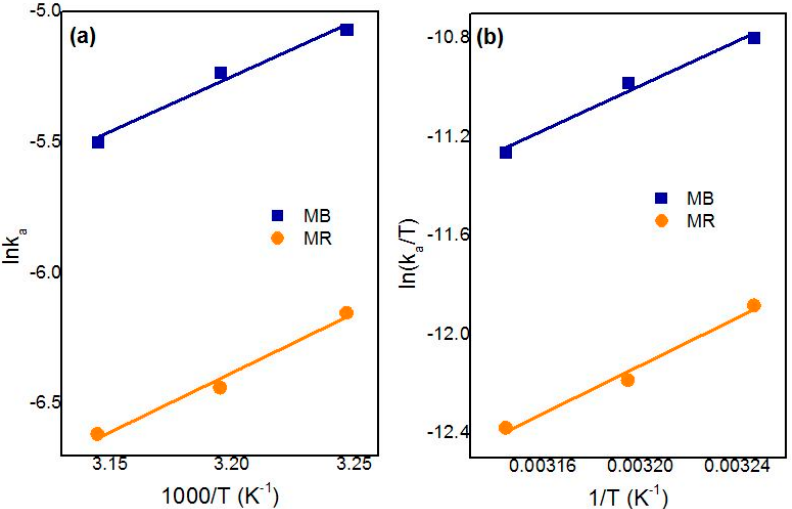
Figure 15. ( a ) Arrhenius plot and ( b ) Eyring plot for the photocatalytic degradation process of MB and MR.